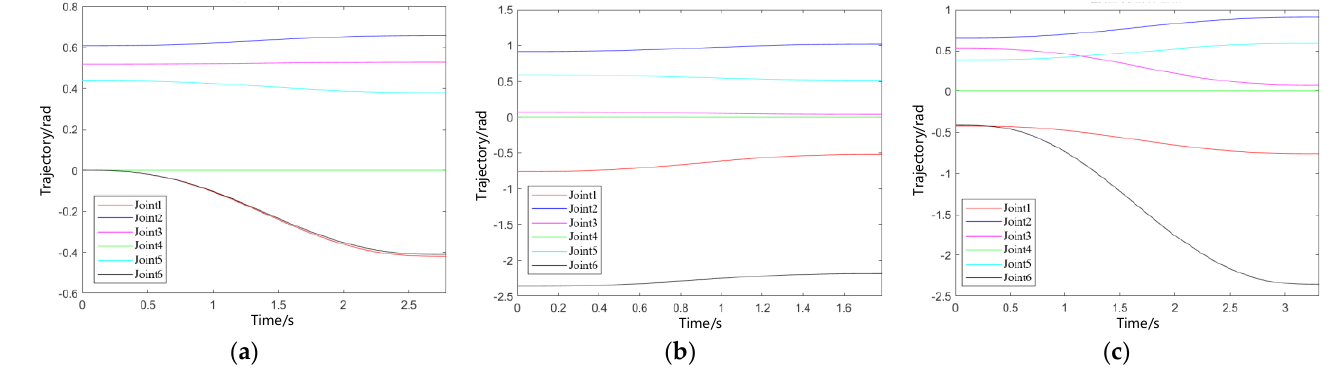
Figure 14. Time-optimal trajectory planning by the improved PSO: ( a ) section AB t 1 trajectory; ( b ) section AB t 2 trajectory; ( c ) section AB t 3 trajectory.